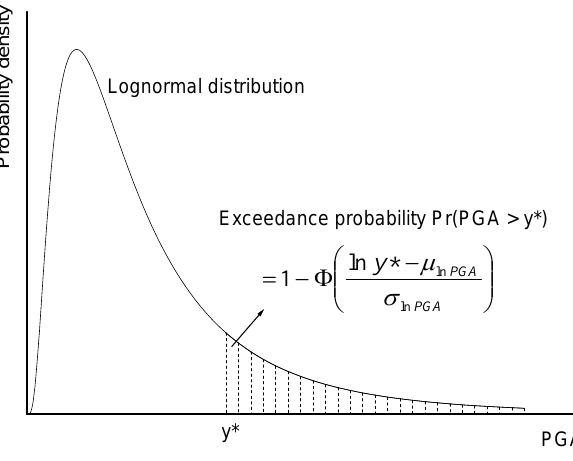
Fig. 2. A schematic diagram showing the PGA exceedance probability given its probability distribution